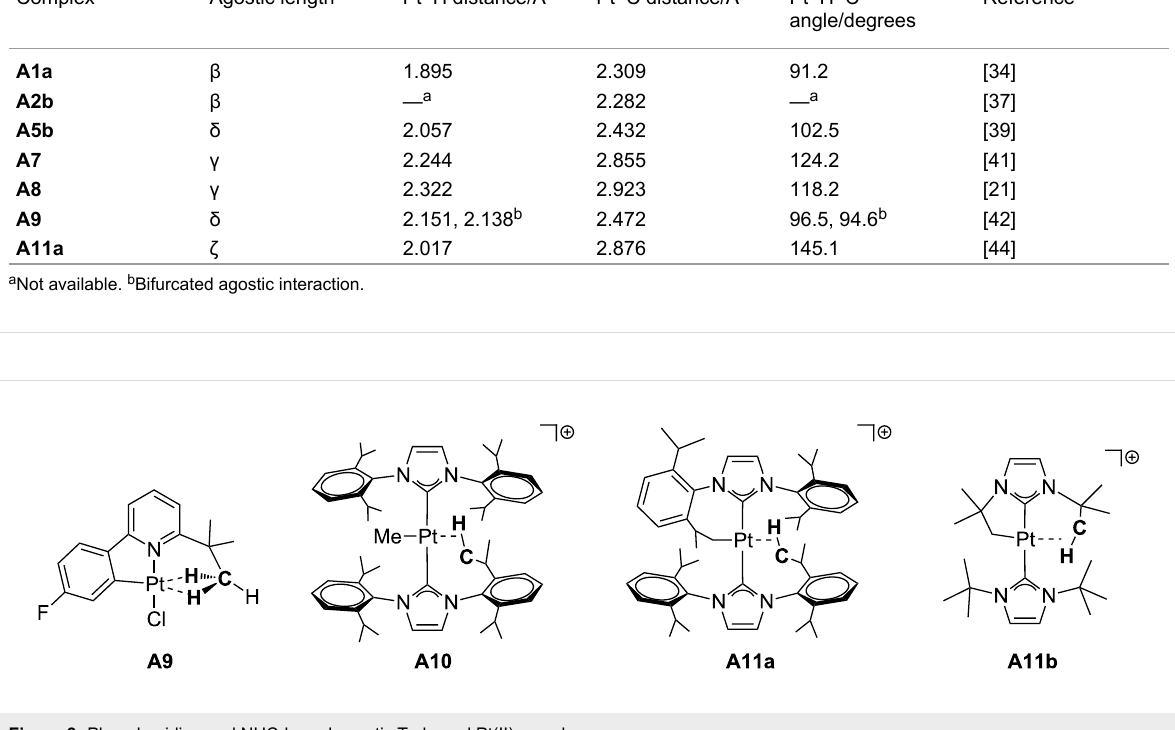
Table 1: Selected geometrical parameters of X-ray characterized agostic T-shaped Pt(II) structures. Complex